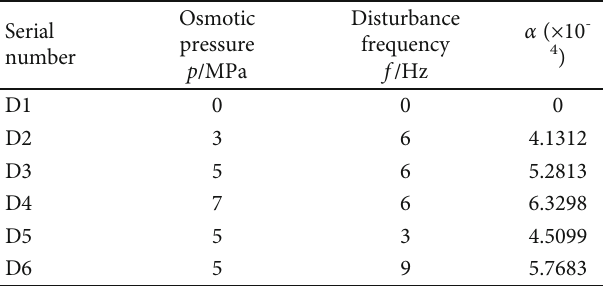
Table 2: Disturbance